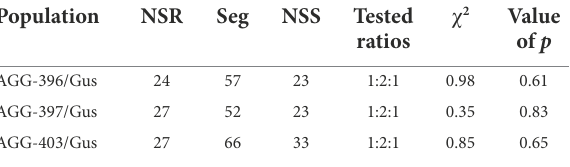
TABLE 5 Distribution and Chi-squared analysis of F 3 families derived from crosses between AGG-396/Gus, AGG-397/Gus, and AGG-403/ Gus when tested against Puccinia hordei pathotype 5457 P+ in greenhouse.